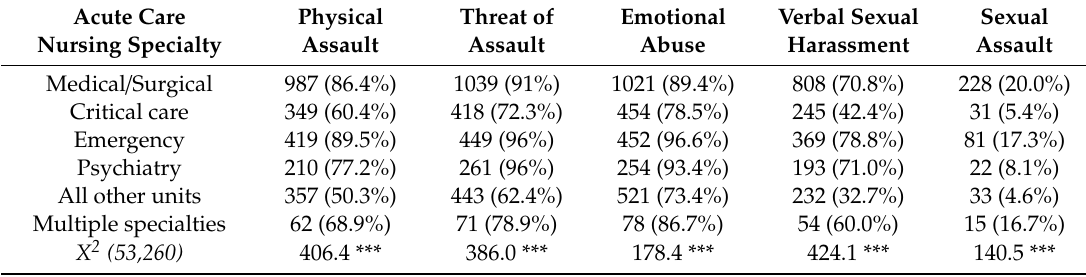
Table 3. Percentage of acute care nurses who reported workplace violence by nursing specialty. Acute